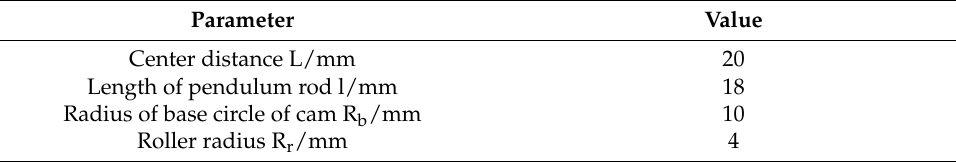
Table 1. The dimension parameters of the double-cam